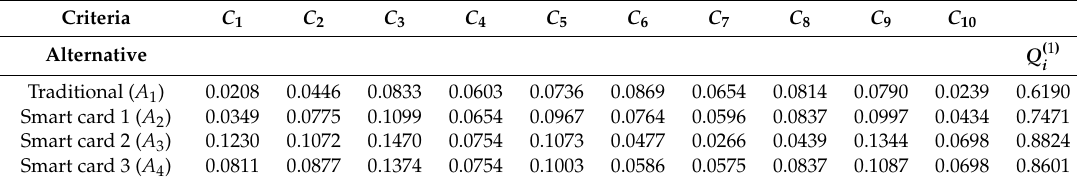
Table 6. Total relative importance values of alternatives by WSM method.